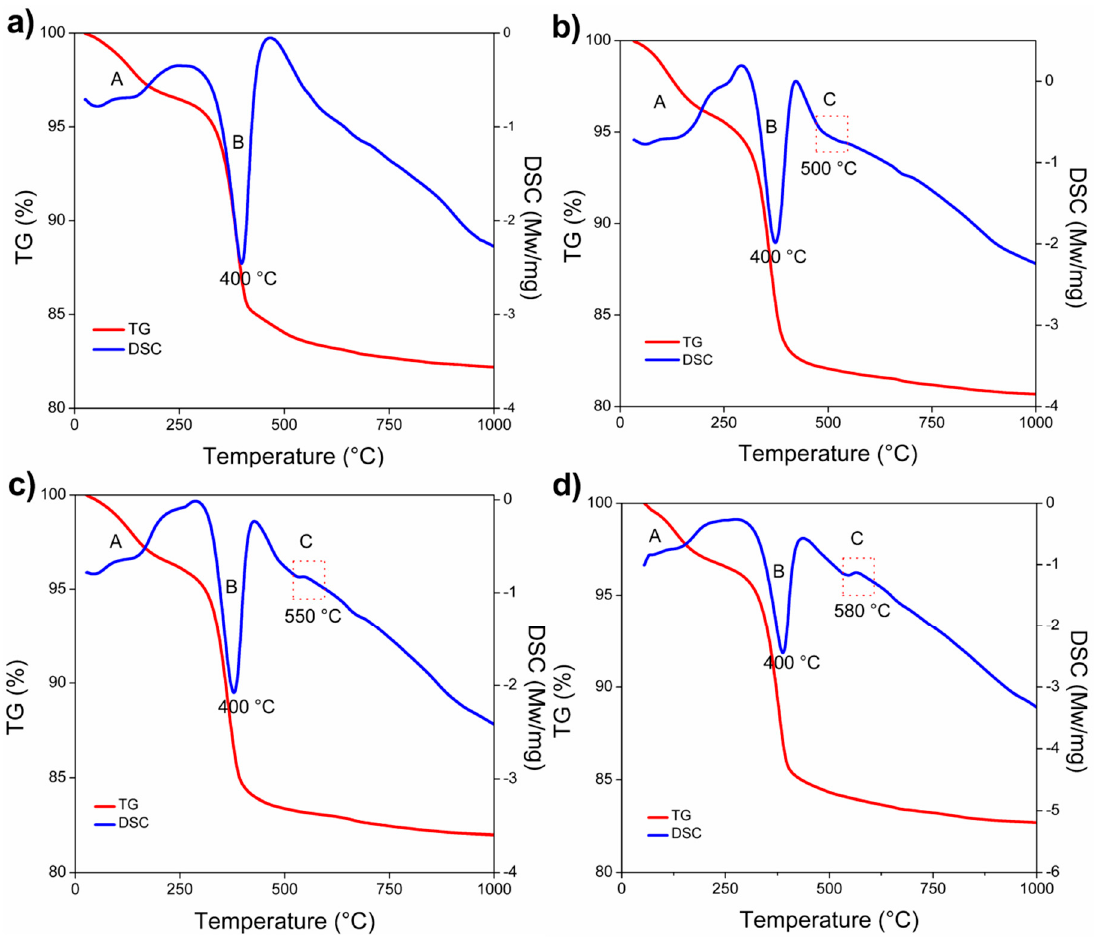
Figure 11. DSC-TGA results of samples: ( a ) MgO, ( b ) 1 wt.% Al 2 O 3 , ( c ) 3 wt.% Al 2 O 3 , and ( d ) 5 wt.% Al 2 O 3.